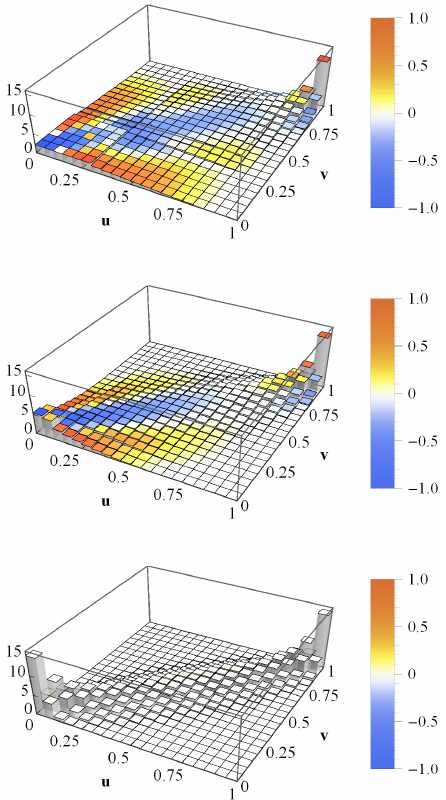
Figure 12. Average loss copula histograms for homogeneous portfolios with asset correlations c = 0.3. The asset values are multivariate log-normal ( N 3 10 − 4 day − 1 ( middle ) and × from the corresponding Gaussian copula. Taken from (Sicking et al.